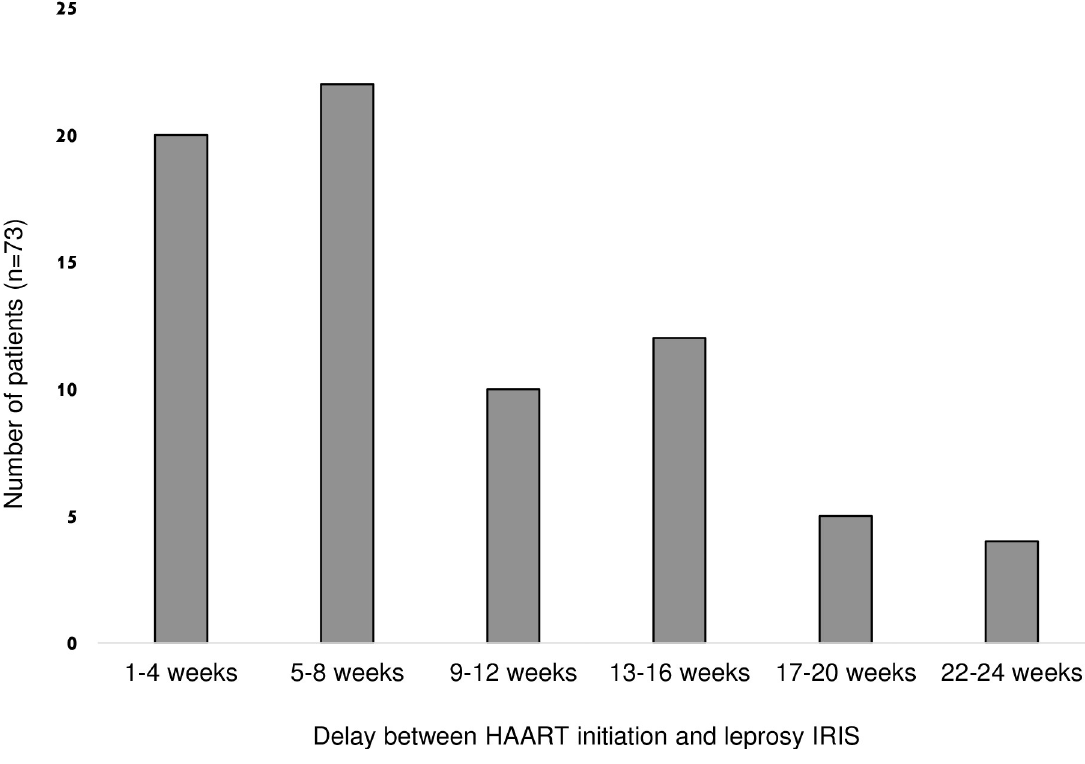
Fig 7. Distribution of patients according to time from HAART introduction to leprosy IRIS.